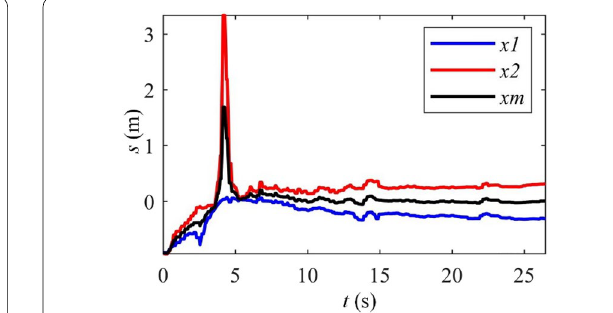
Figure 18 X ‑direction coordinates